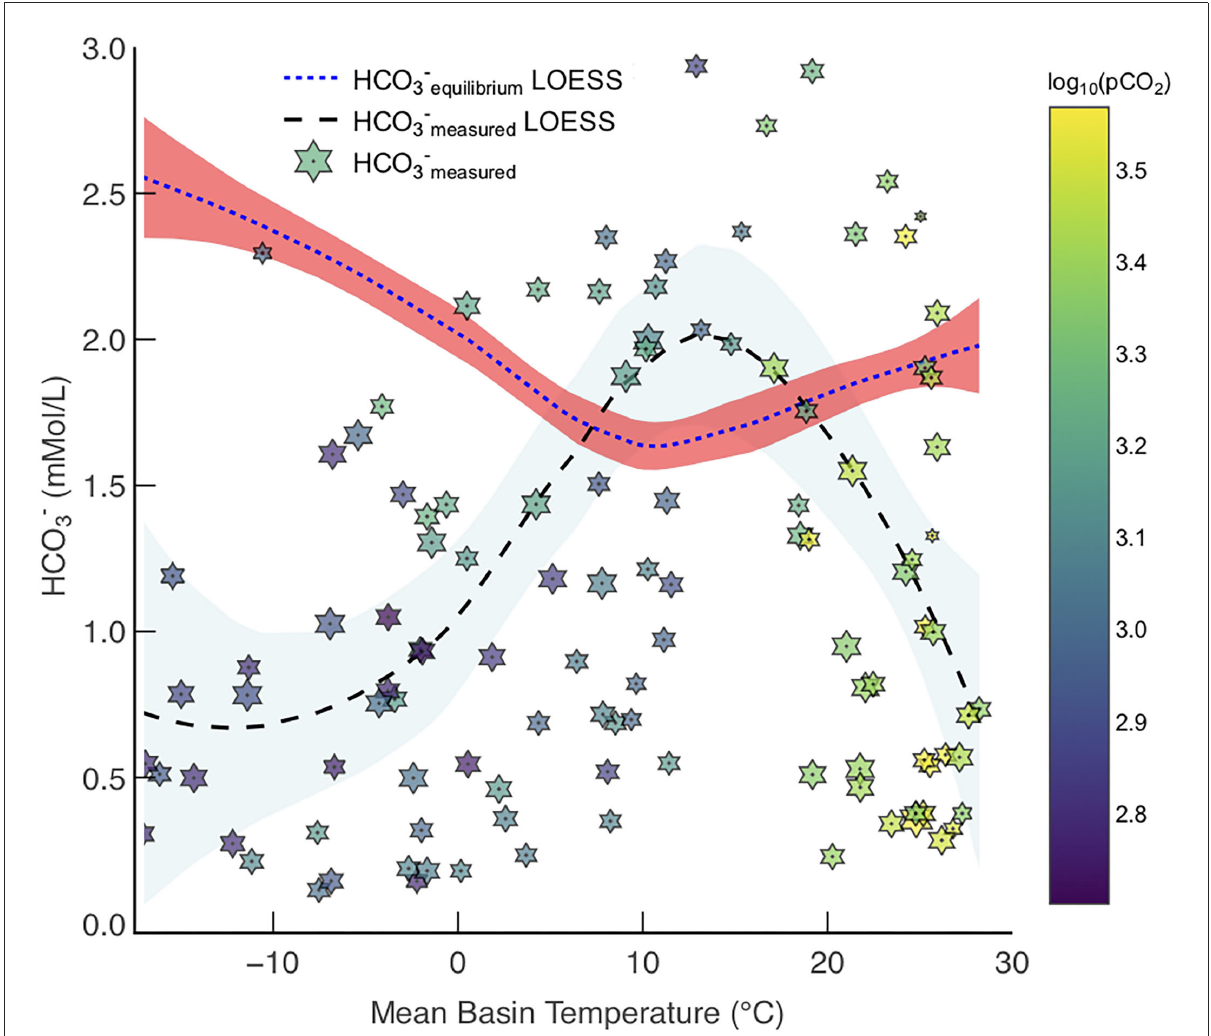
FIGURE7 Measured HCO – 3 concentrations in rivers from the GEMS database, HCO – 3measured , with LOESS fit (star markers and black dashed line with blue CI) and maximum achievable HCO – 3 concentration from enhanced carbonate weathering, HCO – 3equilibrium , at SIc = 0 (Model 2) with LOESS fit (blue dashed line with red CI). Points are coloured by log 10 (pCO2) and sized based on relative log 10